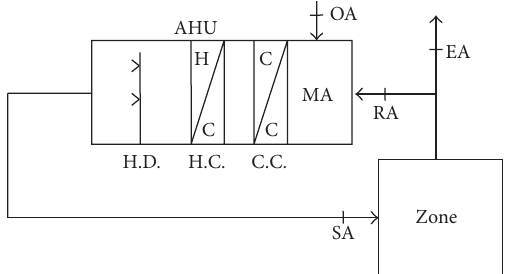
Figure 1: Controlled temperature and humidity of air conditioning system thermal model